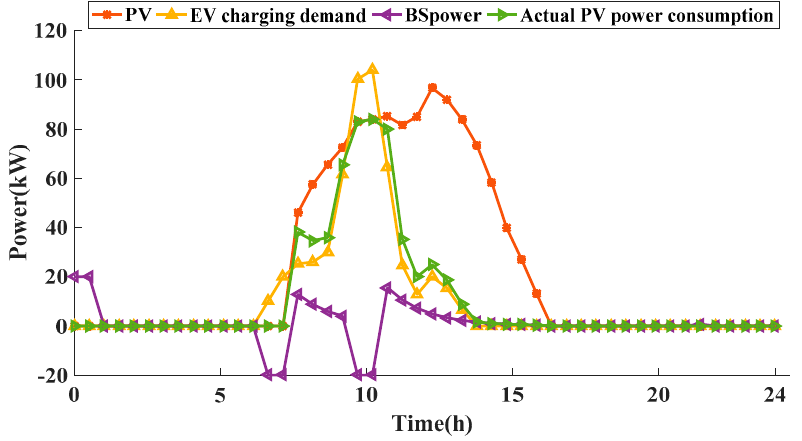
Figure 10. The output of each unit of the parking lot.